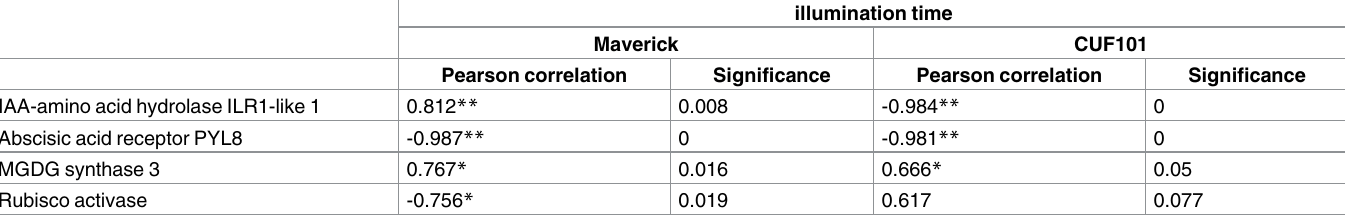
Table 5. Correlation between mRNA abundance in the leavesof Maverickand CUF101varietiesand illumination time under artificial growth conditions.